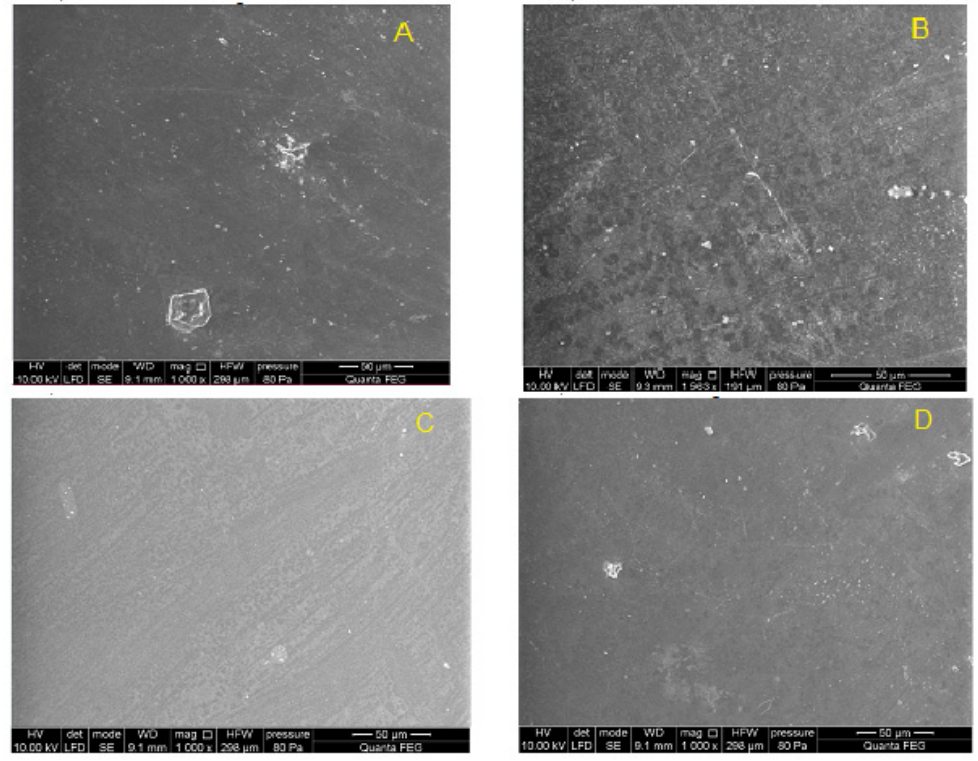
Figure 13. Surface of PET-DLA 70 copolymer: ( A ) not implanted, and ( B , C , D ) after 12-week implantation period.